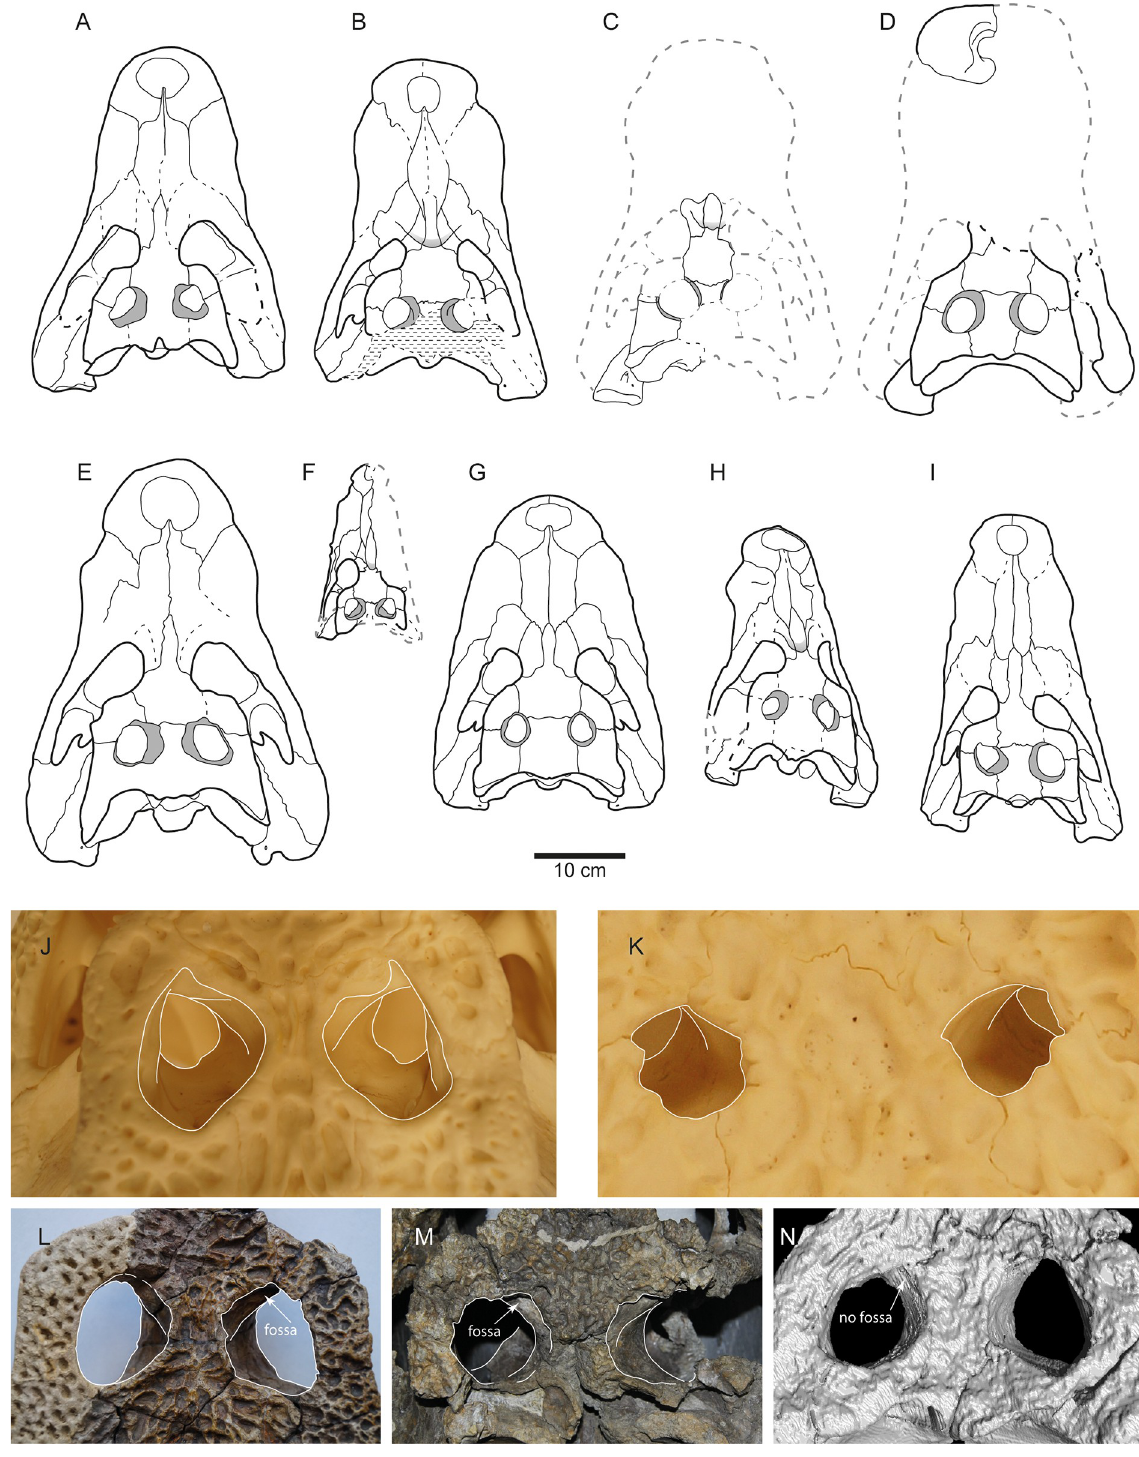
Fig 1. Skulls of allodaposuchid taxa in dorsal view. A) Allodaposuchus precedens . B) Allodaposuchus subjuniperus . C) Allodaposuchus palustris . D) Allodaposuchus hulki . E) Allodaposuchus iberoarmoricanus . F) Arenysuchus gascabadiolorum . G) ‘ Lohuecosuchus ’ megadontos . H) ‘ Lohuecosuchus ’ mechinorum . I) ‘ Agaresuchus ’ fontisensis . J-N) Detail of the supratemporal fossa in Crocodylus niloticus (J), Osteolaemus tetraspis (K), Allodaposuchus precedens (L), Allodaposuchus subjuniperus (M), and Allodaposuchus hulki (N). Fig M, courtesy of Dr. Eduardo Pue´rtolas Pascual. Fig N is a detail of the CT-scan of Allodaposuchus hulki , courtesy of Dr. Josep Fortuny.